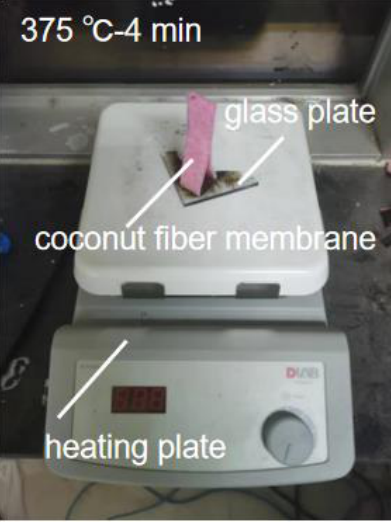
Figure 1. Carbonization of the coconut fiber membrane.